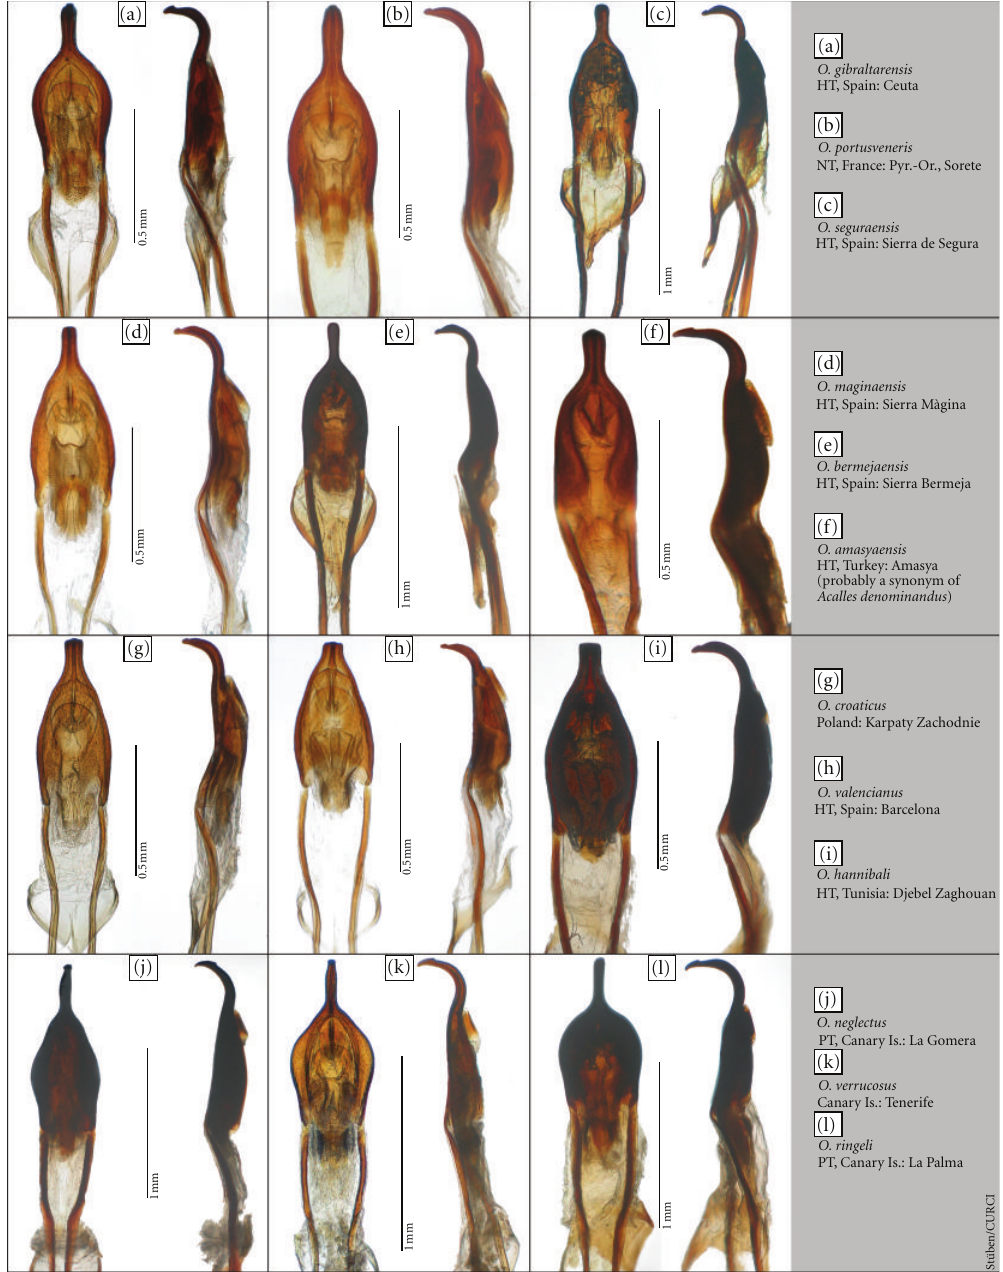
Figure 9: (a–d): Portusveneris group — O. gibraltarensis (a), O . portusveneris (b), O . seguraensis (c), O . maginaensis (d), and O . bermejaensis (e); (f): Incertaesedis — O. amasyaensis ; (g–i): Henoni group — O. croaticus (g), O . valencianus (h), O. hannibali (i) (see also the other species of this group: Figures 5(c), 5(f), 5(j), 5(n)); (j–l): subgenus: Araneacalles — O. neglectus (j) , O. verrucosus (k), and O. ringeli (l). — Henoni group — (10) Elytra flat, without (10) Elytra with superelevated and in tubercles dissected intervals; a species from southeastern Europe, which is added to the henoni group preliminary on the basis of a similar form of the aedeagus. Habitus (Figure 7(g)). Aedeagus (Figure 9(g)). Distribution: East and Southeast Europe [31]. Onyxacalles croaticus (H. Brisout de Barneville, 1867) [10]